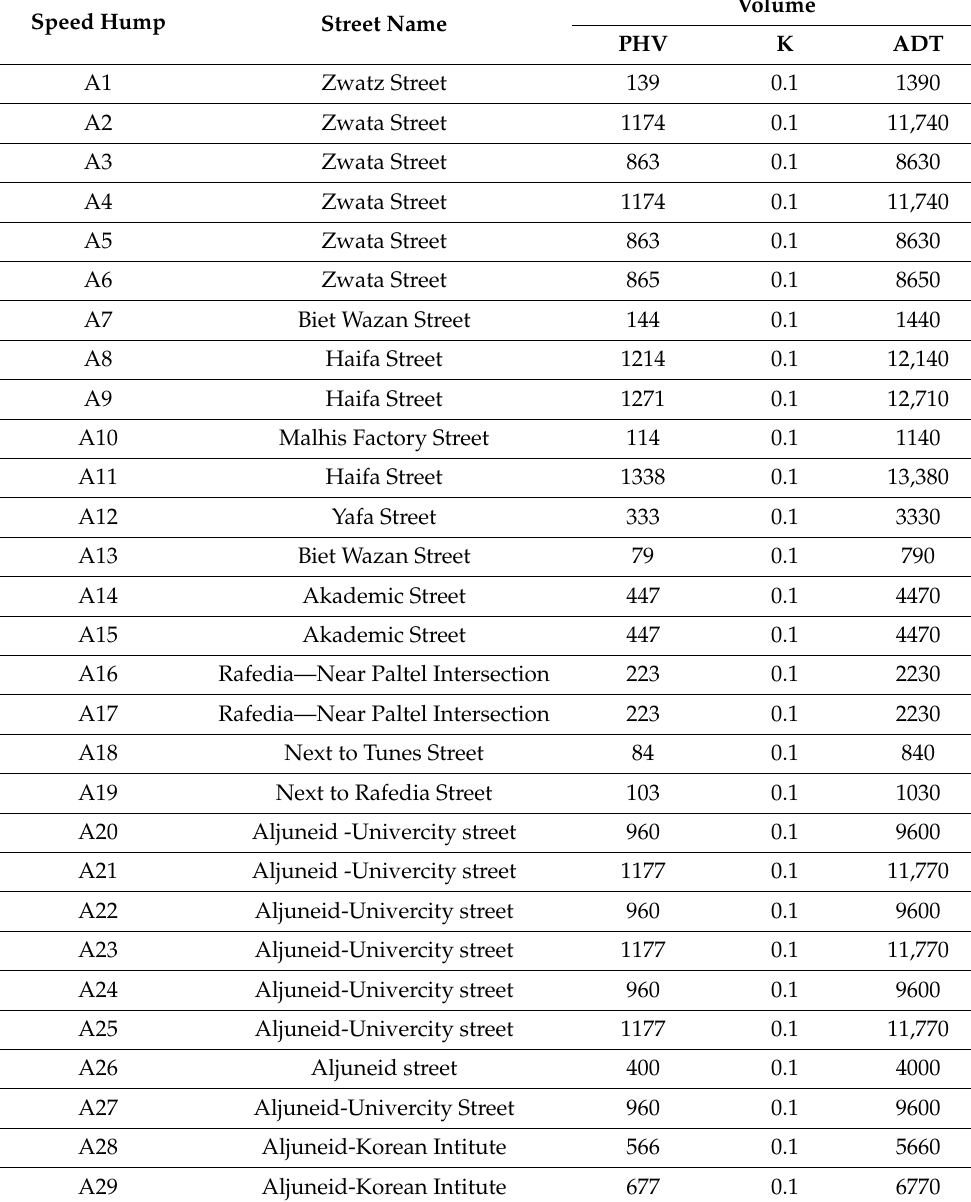
Table 2. ADT calculation for speed humps in zone